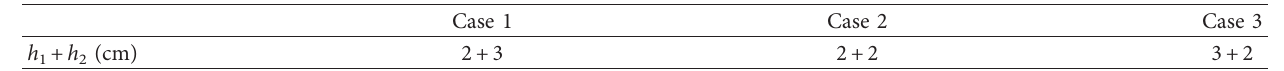
Figure 13: Vertical displacement and stresses (Case 2): (a) vertical displacement in shell; (b) stress σ x of top surface in shell; (c) stress σ x of bottom surface in shell; (d) stress σ y of top surface in shell; (e) stress σ y of bottom surface in Table 3: Thickness of layers with the following 3 cases studied.